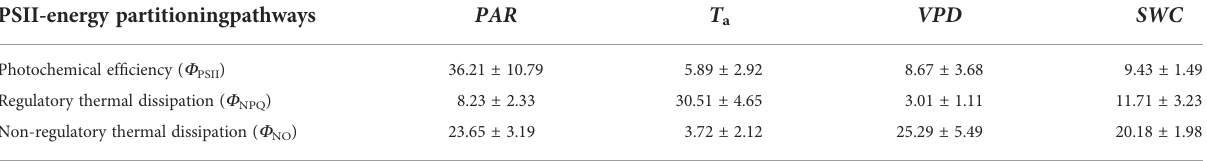
TABLE 2 Time lags between PSII-energy partitioning pathways and environmental factors on a monthly timescale [i.e., photosynthetically active radiation ( PAR ), air temperature ( T a ), vapor pressure de fi cit ( VPD ), and soil water content at a 0.3-m depth ( SWC )]. PSII-energy